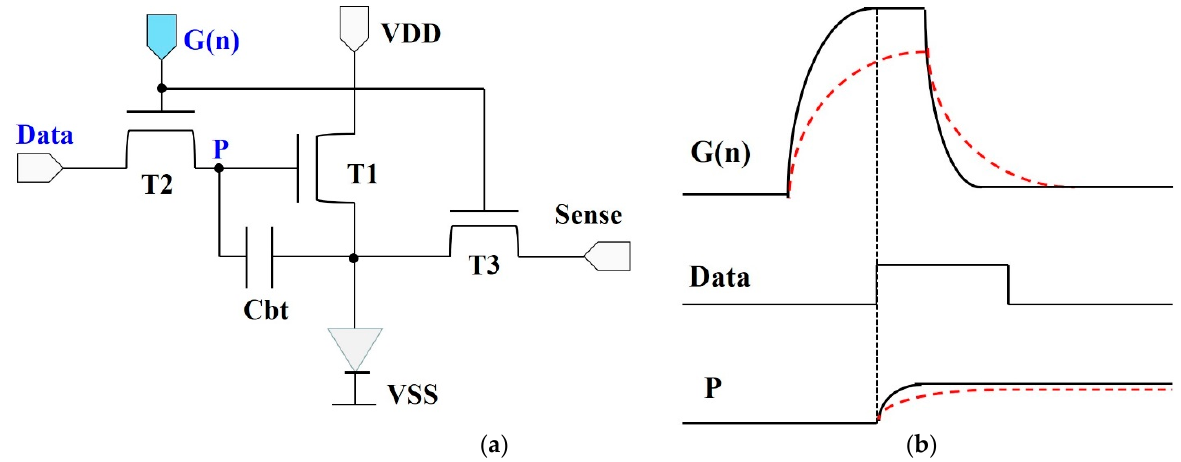
Figure 9. ( a ) The schematic diagram and ( b ) the charging diagram of pixel circuit in AMOLED displays.